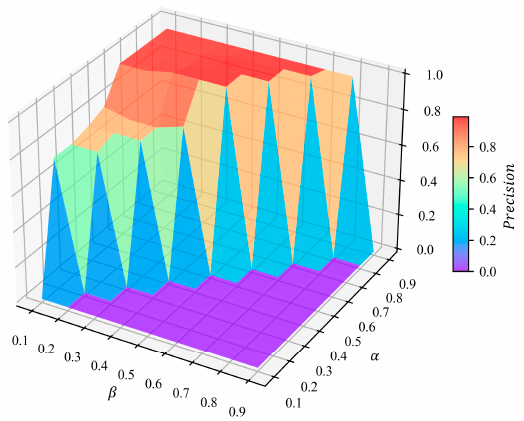
Figure 4. Breast’s 𝑃𝑟𝑒𝑐𝑖𝑠𝑖𝑜𝑛 change chart.